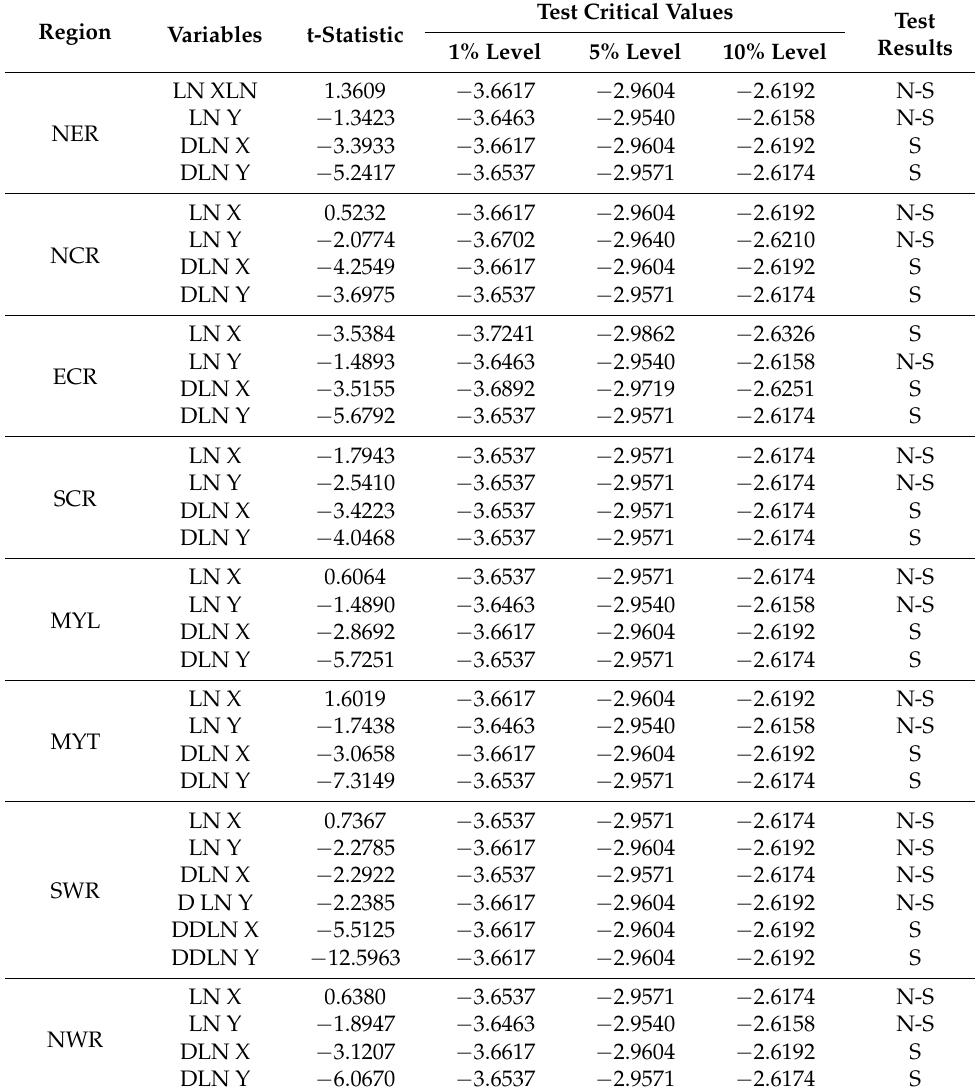
Table 5. Results of panel unit root tests for various